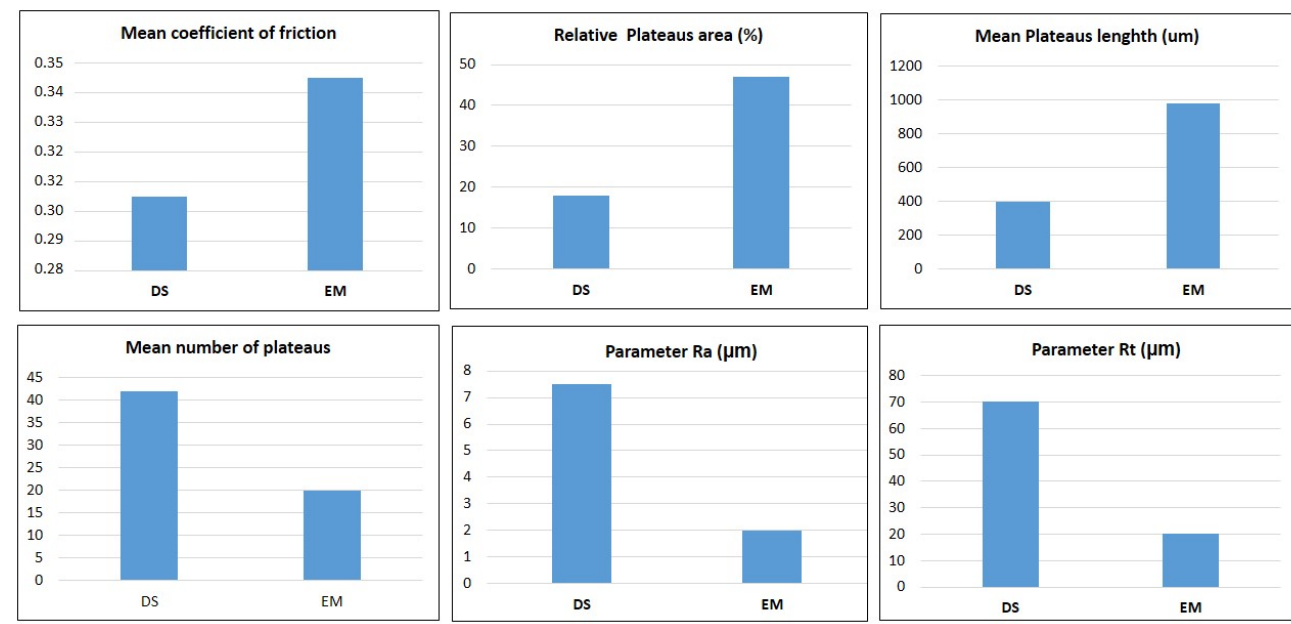
Figure 6. Main effect plots.